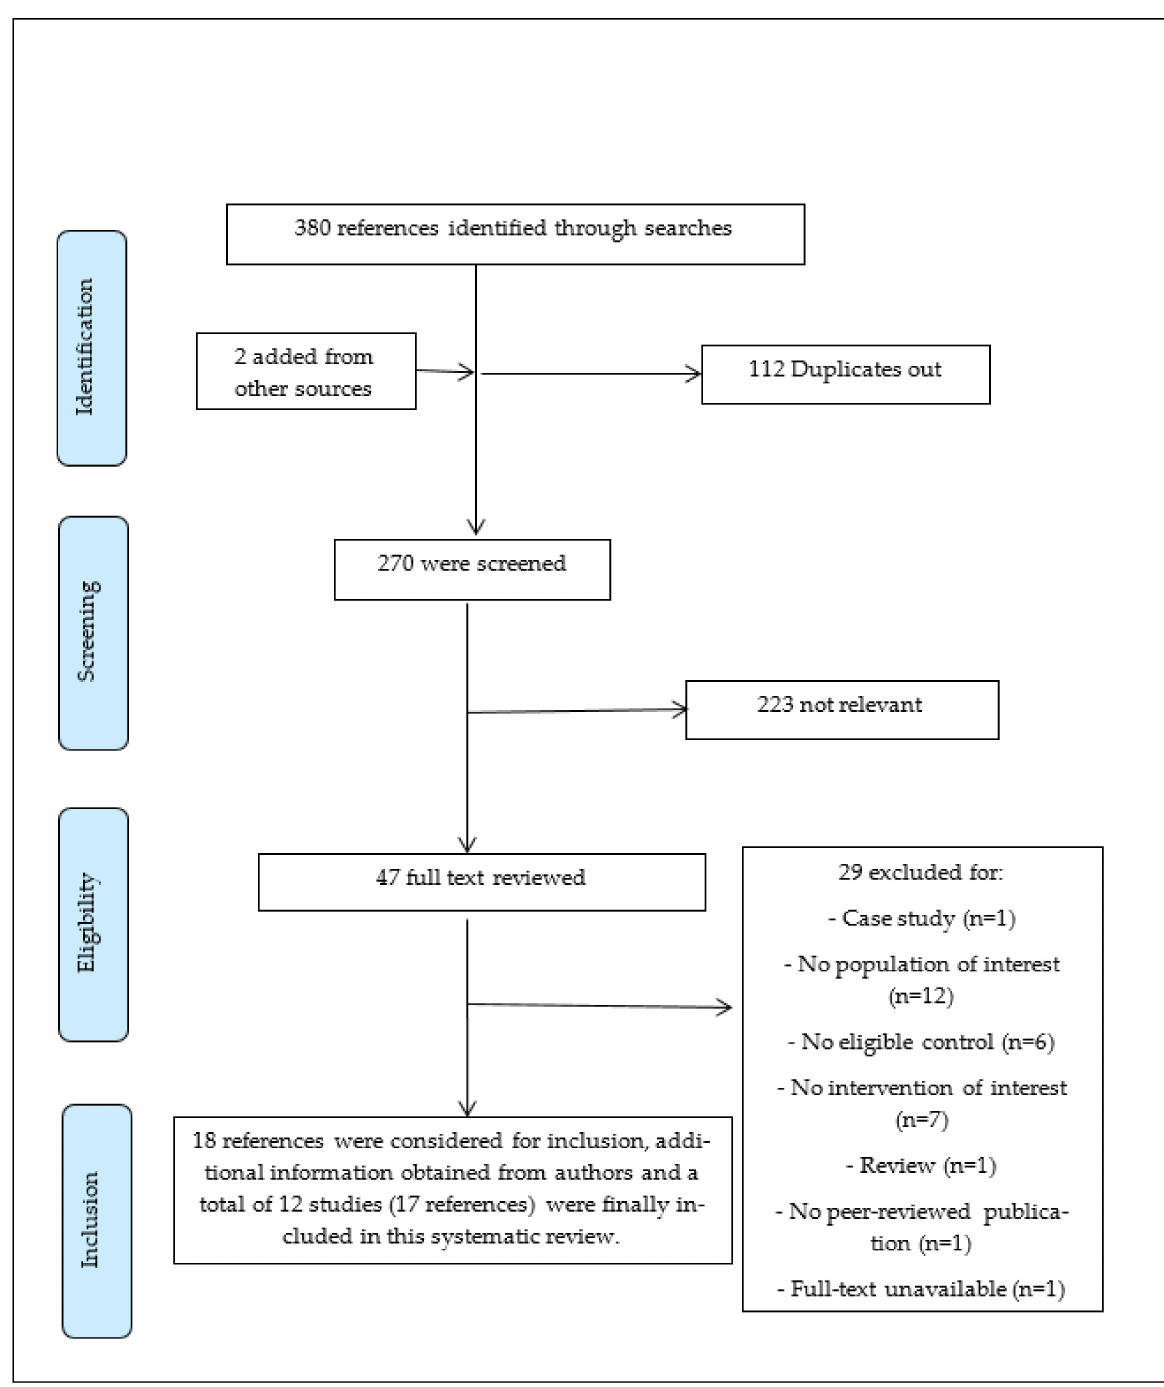
Figure 1. Adapted version of PRISMA flow diagram of study selection for the ME/CFS systematic